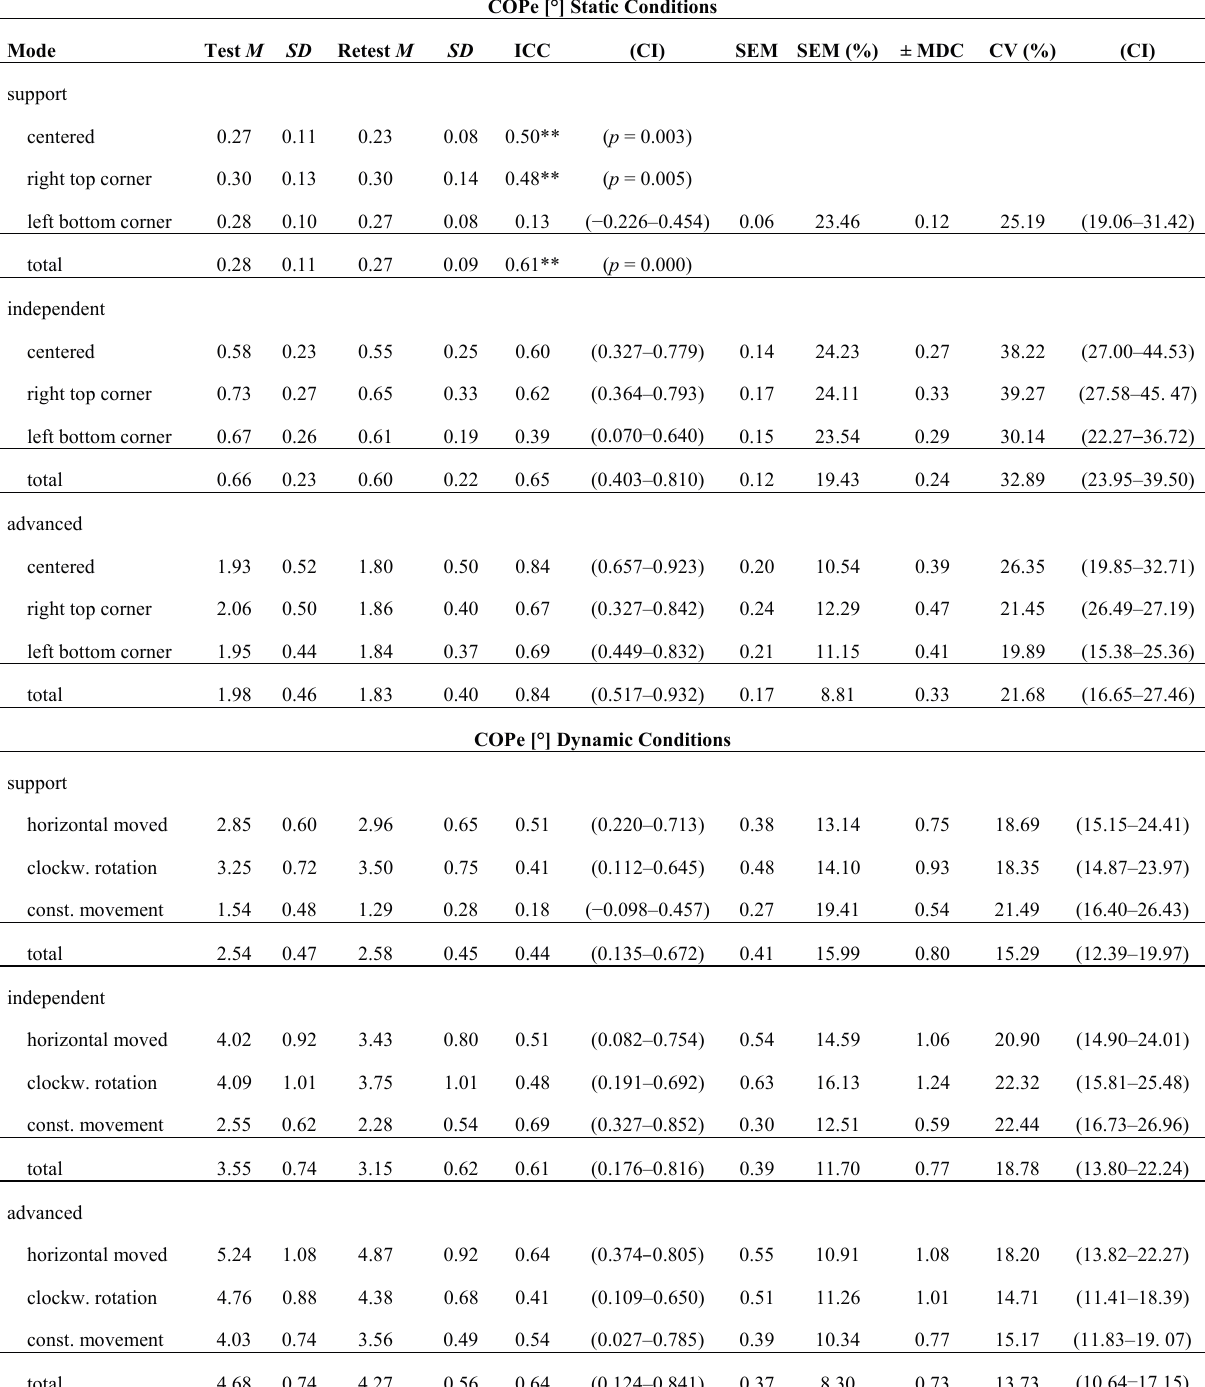
Table 3. Test-Retest reliability analysis of the COP error in three different exercises and three different conditions of postural difficulty ( n =